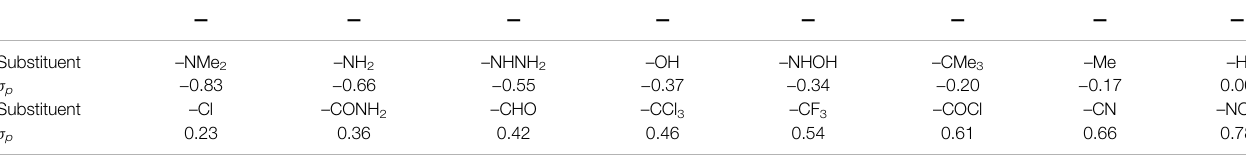
TABLE 1 | Hammett constant values σ p for the sequence of the analyzed substituents (Hansch et al.,